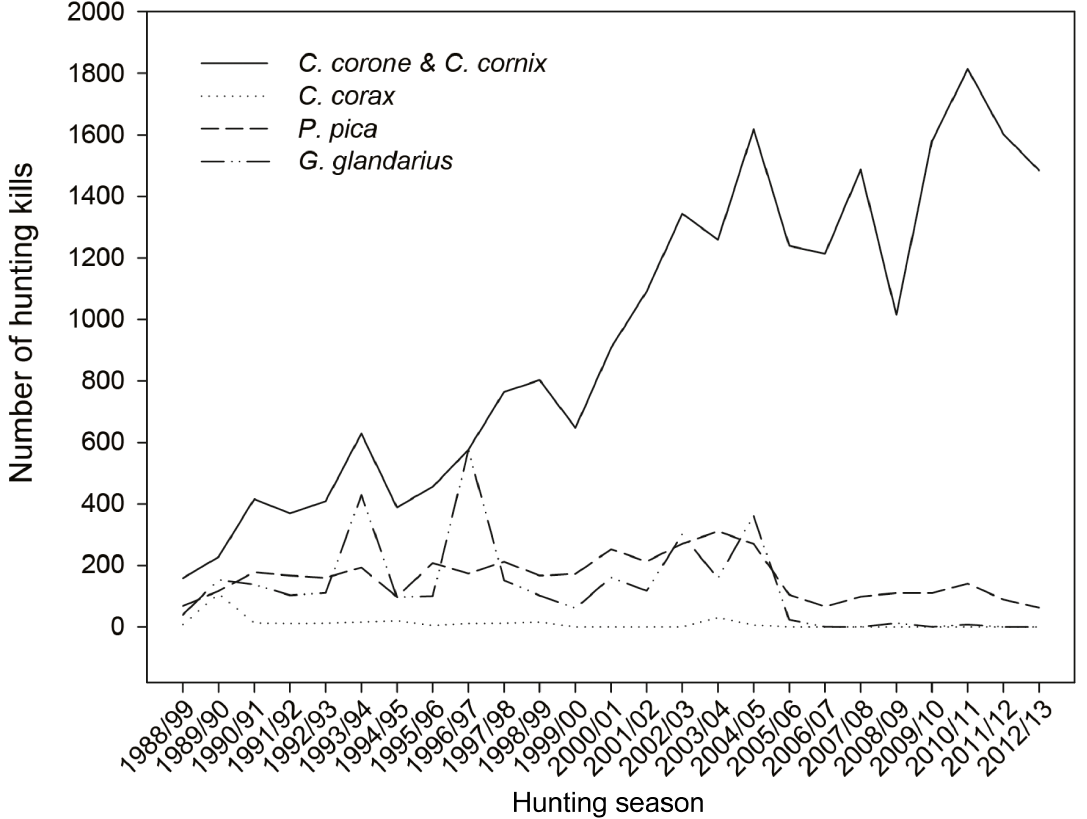
Figure 3. Hunting kills of corvid species ( Corvus corone , C. cornix , C. corax , Pica pica , and Garrulus glandarius ) during the annual hunting seasons from 1988 to 2013 in Vorarlberg, Austria.